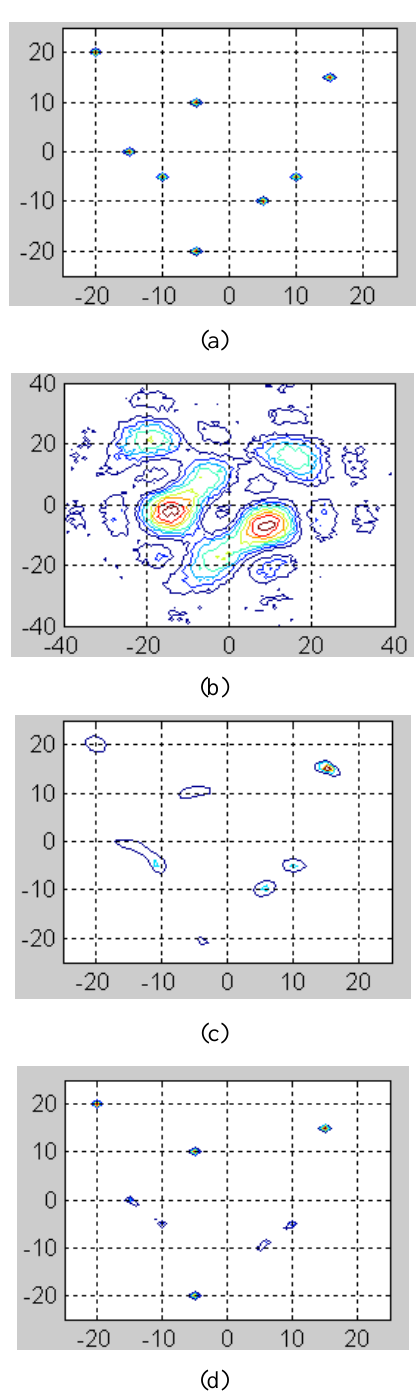
Fig.3. Simulated point scatters images. (a) The targets’ position. (b) Fourier imaging. (c) AWNE. (d) Method in the